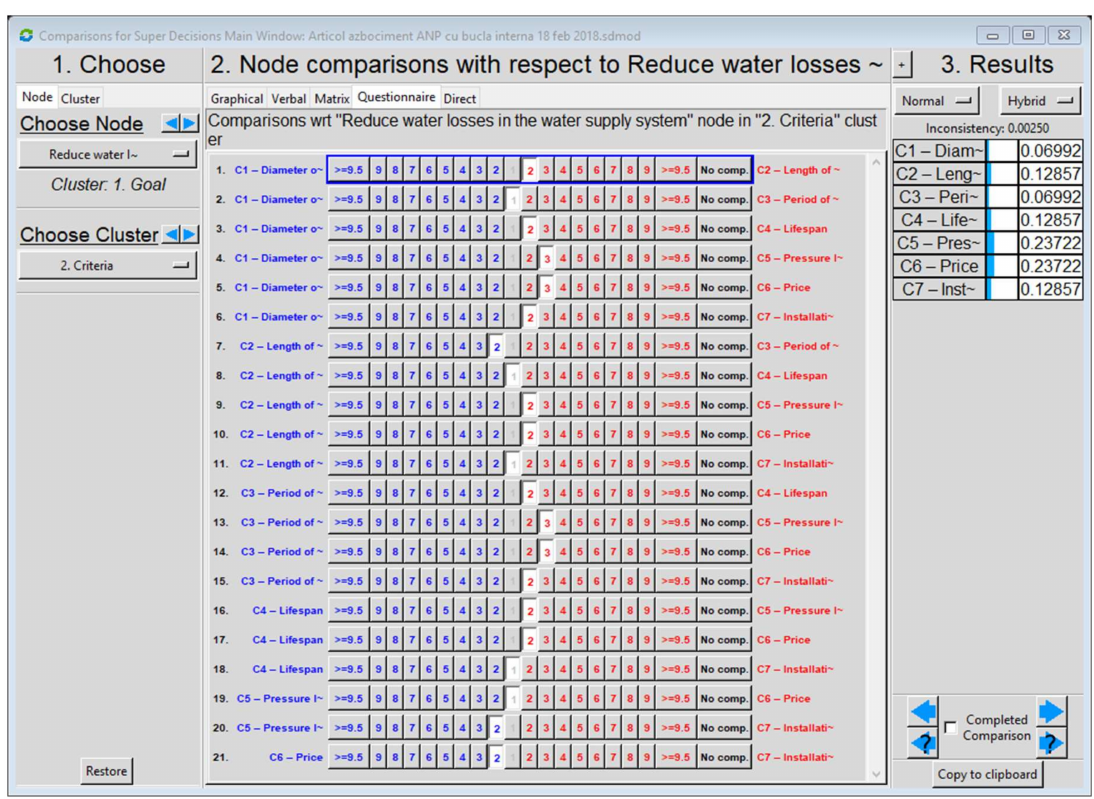
Figure 5. The questionnaire used for pair comparison between the seven decision-making criteria. The pair comparisons are made based on the Fundamental Scale of Saaty.